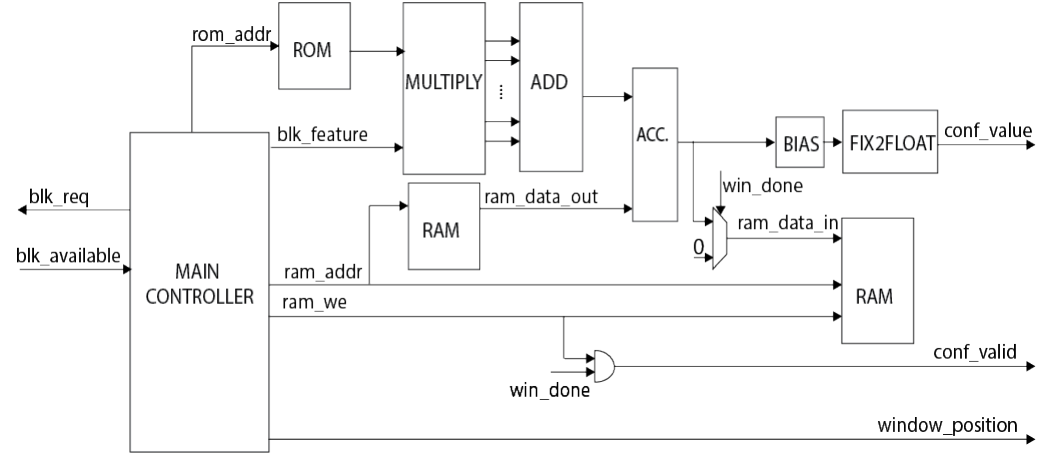
Figure 8. SVM classifier hardware block